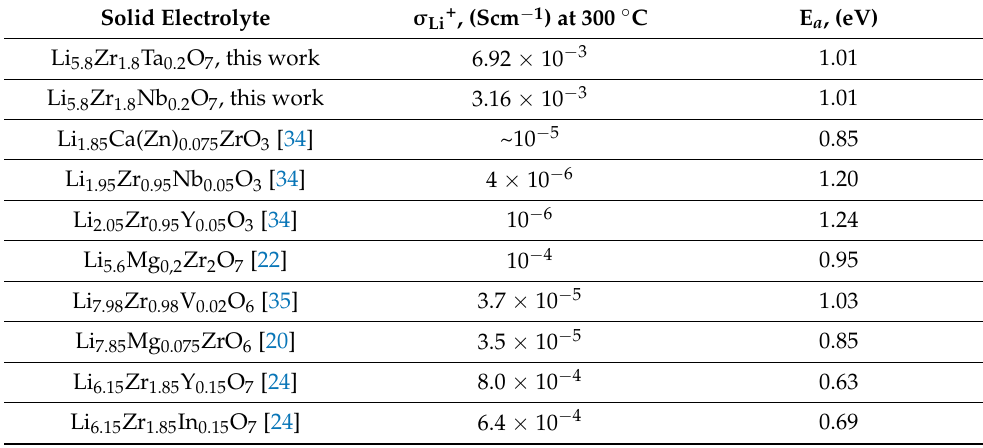
Table 3. Transport properties of some solid electrolytes based on lithium zirconates. Solid Electrolyte